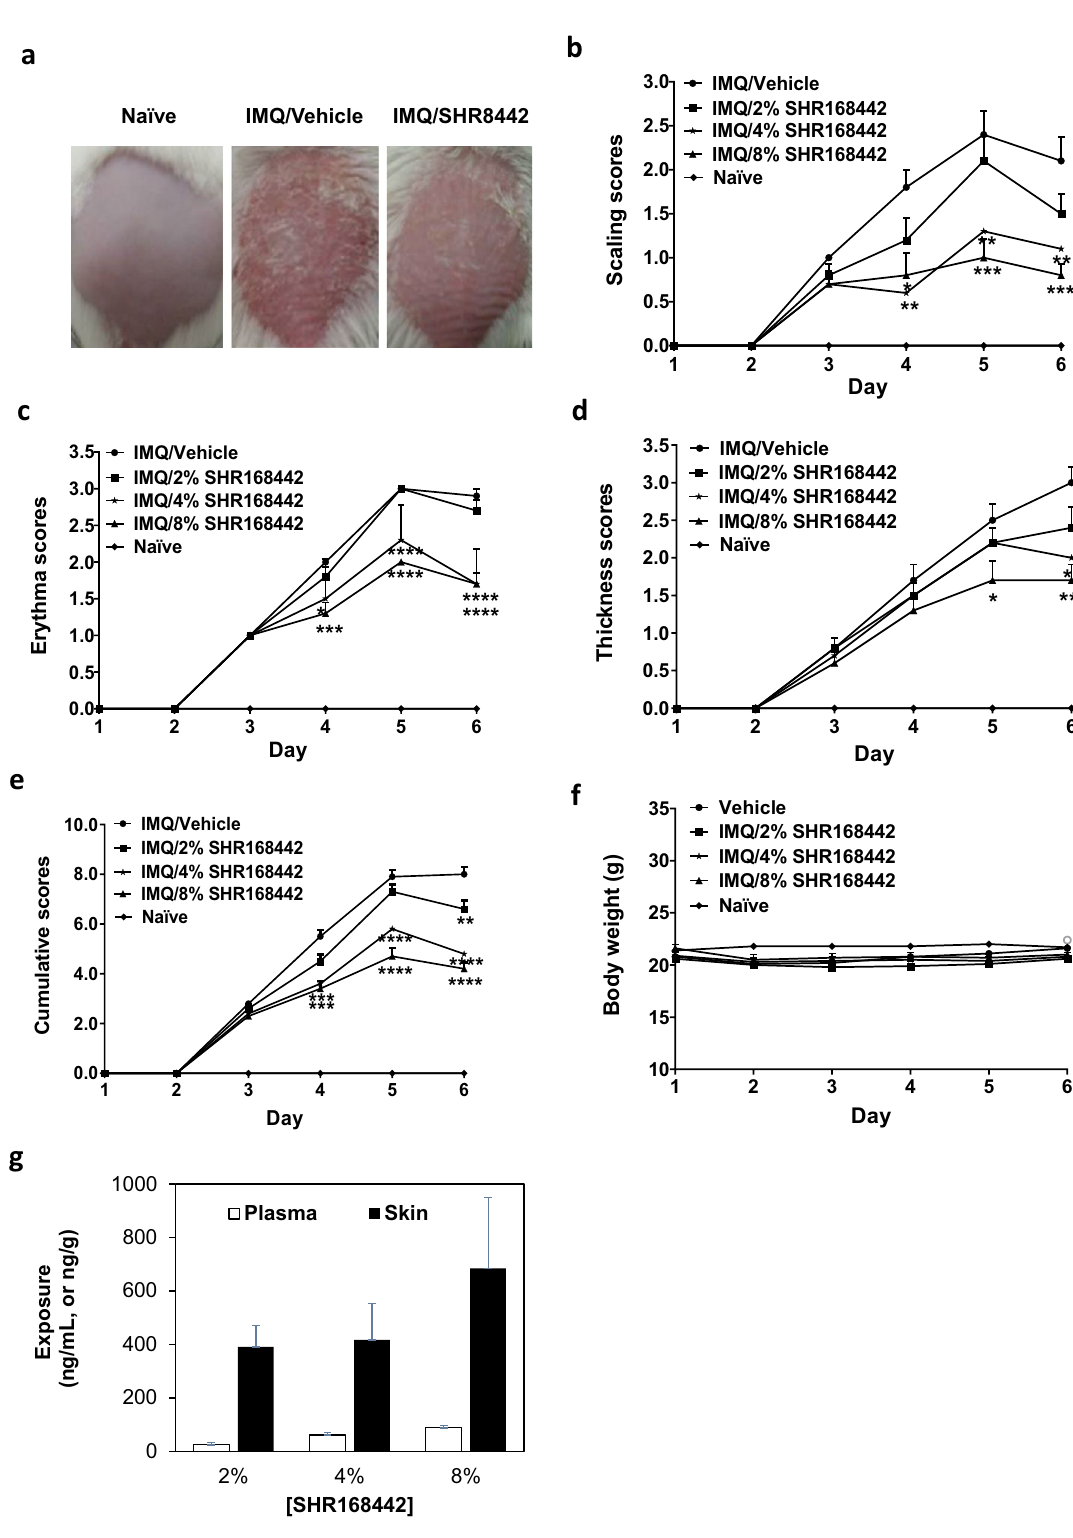
Figure 3. Effect of the topical treatment of SHR168442 in multiple doses (2%, 4% and 8%) in IMQ-induced psoriasis- like skin inflammation mice.( a ) Representative photos of mice in naïve group or the groups of treated topically with IMQ and Vaseline or 8% SHR168442 at day 6. ( b–d ) Scaling ( b ), Erythema ( c ), and thickness ( d ) of the back skin were scored daily on a scale of 0 to 4. ( e ) Cumulative scores were presented as the sum of the scores of scaling, erythema and thickness. Symbols indicated mean score ± SEM of 10 mice per group. Vehicle = Vaseline. Data were analyzed by one-way ANOVA, * p < 0.05, ** p < 0.01, *** p < 0.001, **** p < 0.0001 versus vehicle. ( f ) Body weights of mice were measured daily. ( g ) Exposures of SHR168442 in Vaseline are high in diseased skin and low in plasma in IMQ-induced psoriasis-like skin inflammation mice. The exposure of SHR168442 in dorsal skin (ng/g, black bar) and in plasma (ng/mL, open bar) on day 8 of the study are shown. Symbols indicated mean ± SEM of 4 mice per